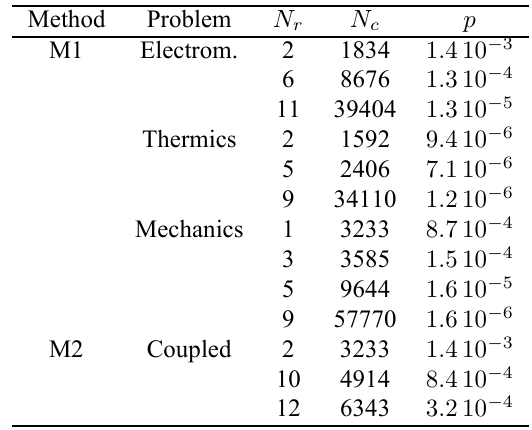
Table 1: Performances of the decoupled (M1) and coupled (M2) methods. N r is the total number of remeshing, the number of cells N c and the precision (maximum of error be- tween adjacent nodes among the whole mesh). For method M1, the final mesh of a problem is not imported in the next one. The computational time is less than 4 min for both methods.